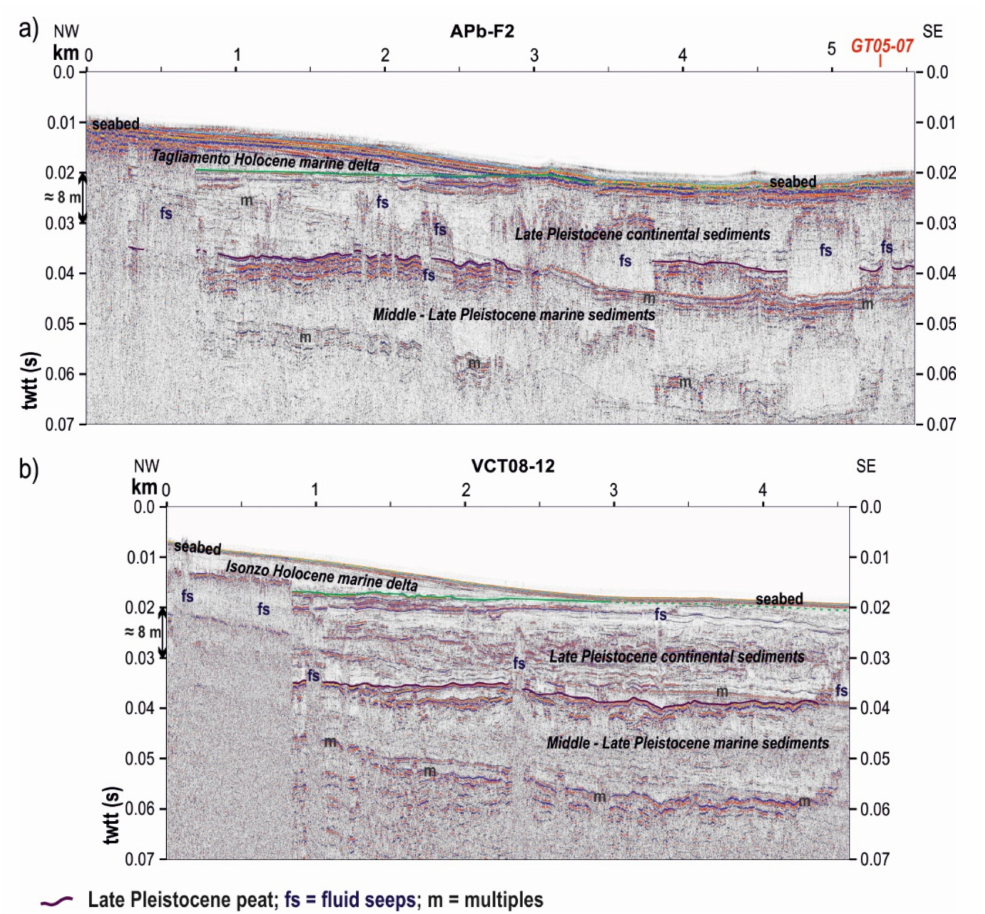
Figure 6. Marine high-resolution boomer profiles APb-F2 ( a ) and VCT08-12 ( b ) offshore the Taglia- mento river delta and Grado Island, respectively. The seismic sections show the sedimentary sequence composed of Middle-Late Pleistocene and Holocene marine and continental sediments whose depo- sition was influenced by the cyclic variations of the sea level in relation to glacial and interglacial phases. The Middle-Late Pleistocene marine sediment related to the Thyrrenian marine transgres- sion (125 ka), are covered in turn by Late Pleistocene continental sediments, characterized by the channel levee system that deposited during the last glacial period in the fluvial plane environment, that may host the shallower aquifer A and possibly aquifer B. The sediments are draped by the prograding Holocene delta front and pro-delta of the Tagliamento and Isonzo rivers, related to the last marine transgression phase. Along the vertical scale of the profiles is reported the approximated correspondent thickness of 0.01 s twt in meters, calculated by using mean P-wave velocity value (obtained through tomographic analysis; [72–75]) of 1750 m/s for the Quaternary sediments. The seismic images show the presence of fluids within the sedimentary sequence. Multiple